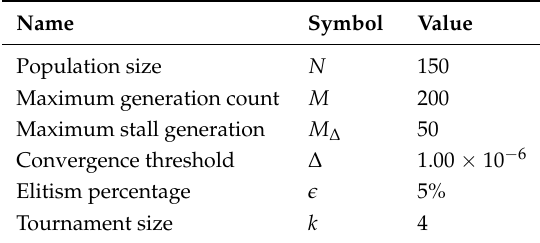
Table 4. Tuning parameters of the genetic algorithm, described in Appendixes A.1–A.6 and shown in red in the flow chart in Figure